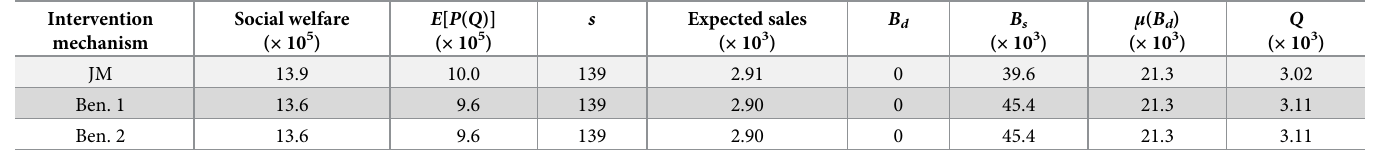
Table 3. The solutions of the basic period given in exponential distribution. Intervention mechanism